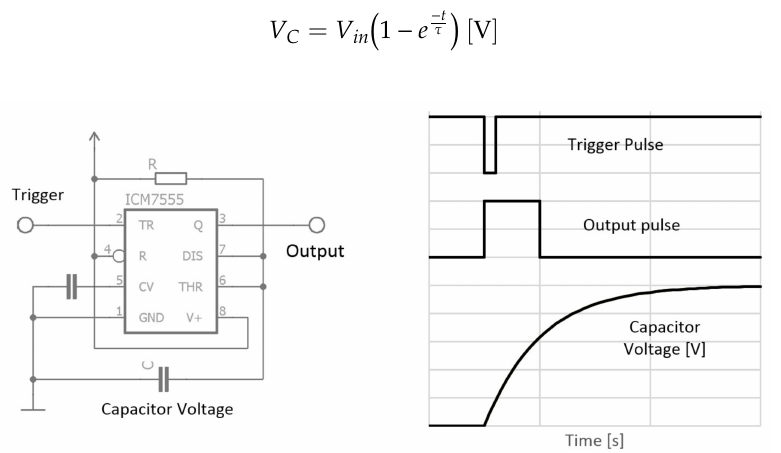
Figure 3. RC circuit improved by a 555 timer chip.